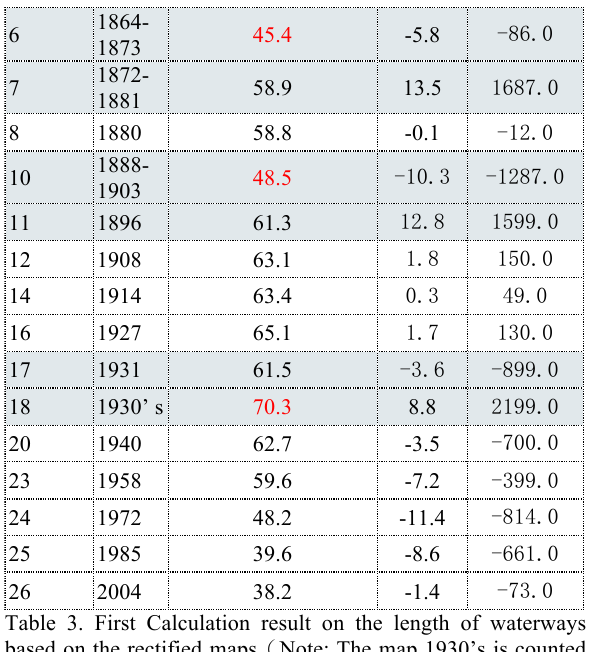
Table 3. First Calculation result on the length of waterways based on the rectified maps （ Note: The map 1930’s is counted